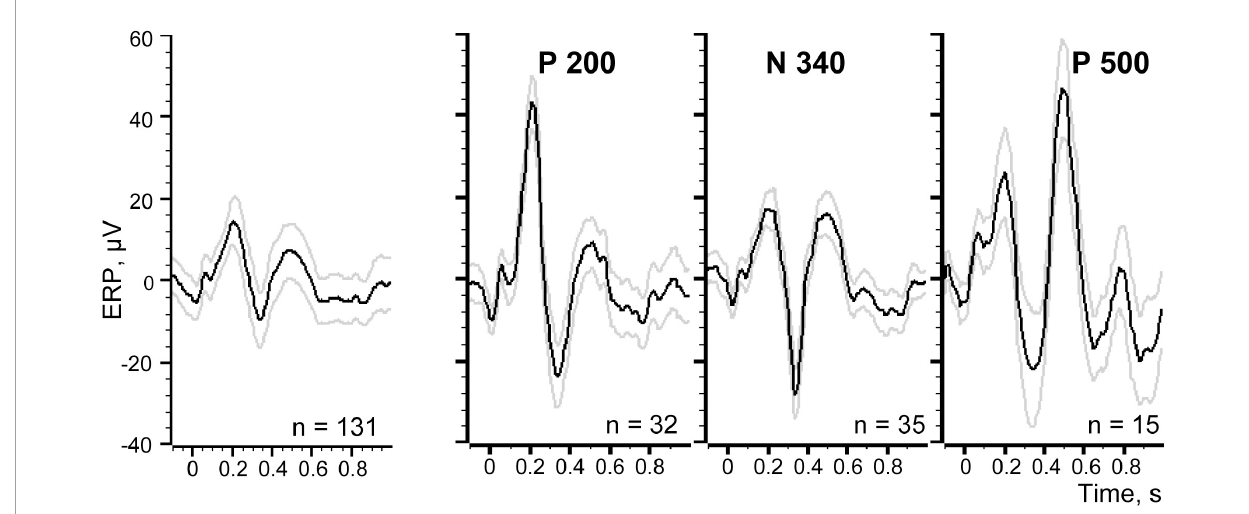
FIGURE8 Evoked responses averaged using different sets of trials. Left panel demonstrates the averaged evoked potential for all 131 trials of the recording session.